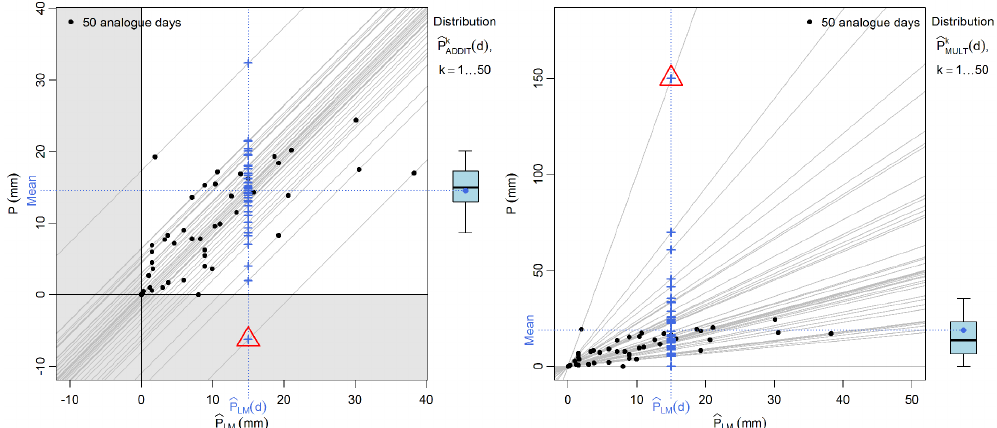
Figure 4. Representation of the additive and multiplicative formulation for precipitation reconstruction from a local model and 50 analogue days for a given day d . Left panel: additive formulation for the correction. Right panel: multiplicative formulation for the correction. The triangles highlight anomalous or potentially anomalous corrected